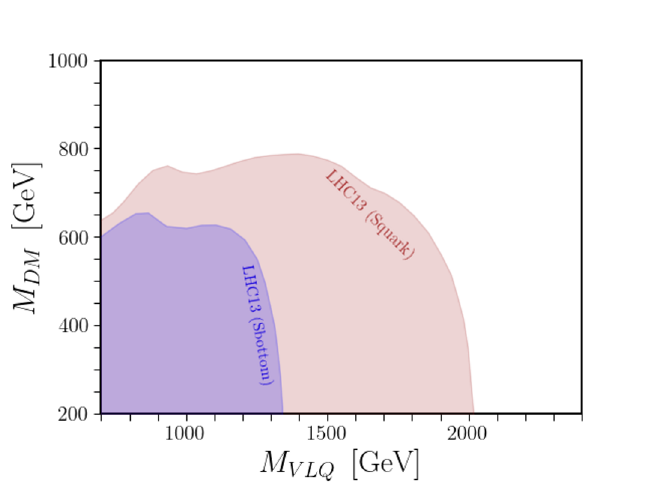
Figure 4 . Current LHC limits on vector-like quarks in the model. The shaded regions are excluded by pp → jj + + /E searches. The inner shaded region corresponds to the jets identified as b T